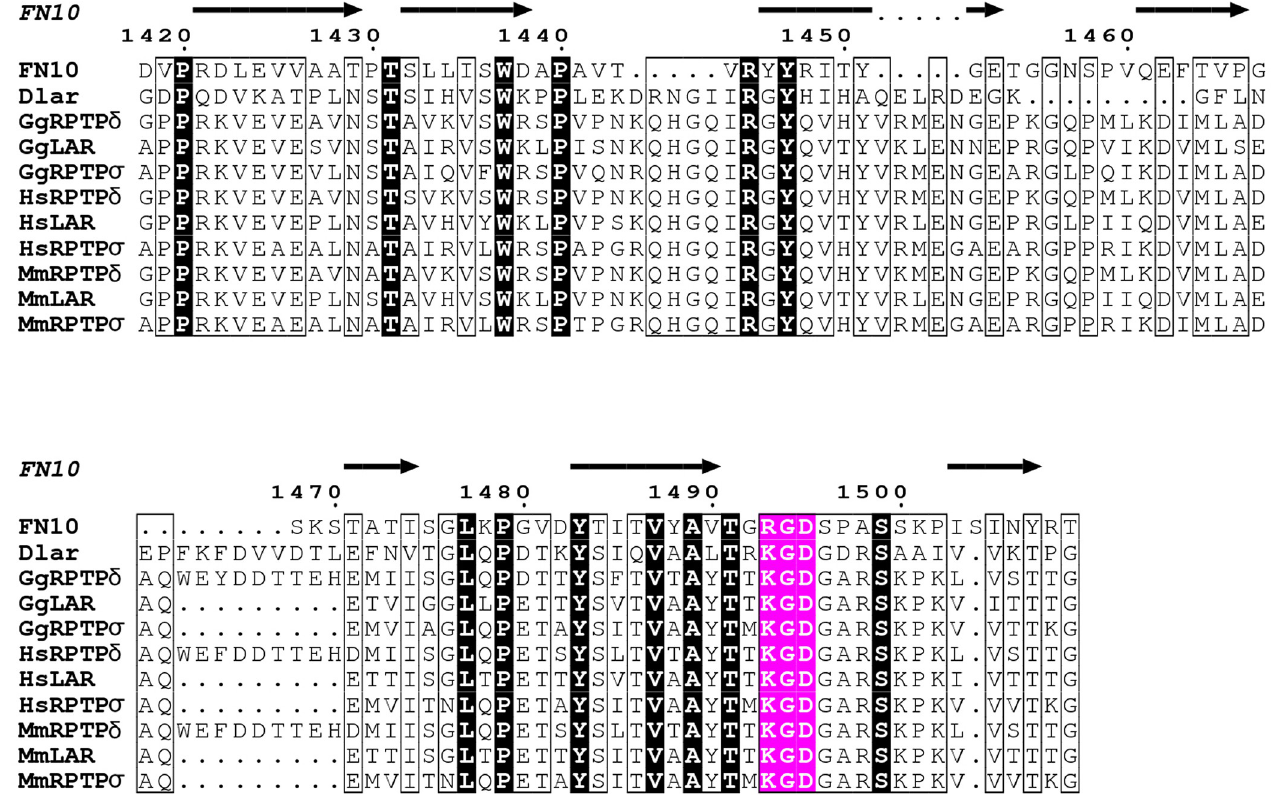
Fig 5. Sequence alignment depicting conservation between the RGD peptide found in domain FN10 of human fibronectin and in the FN5 domains of type IIa RPTPs. The secondary structure element above the structure corresponds to those found in FN10 [57]. Strictly conserved residues are shown in black while the RGD and KGD residues highlighted in magenta. Sequences for the FN5 domains of type IIa RPTPs are from chicken (Gg), human (Hs), and mouse (Mm). The figure was prepared using ESPRIPT [58].